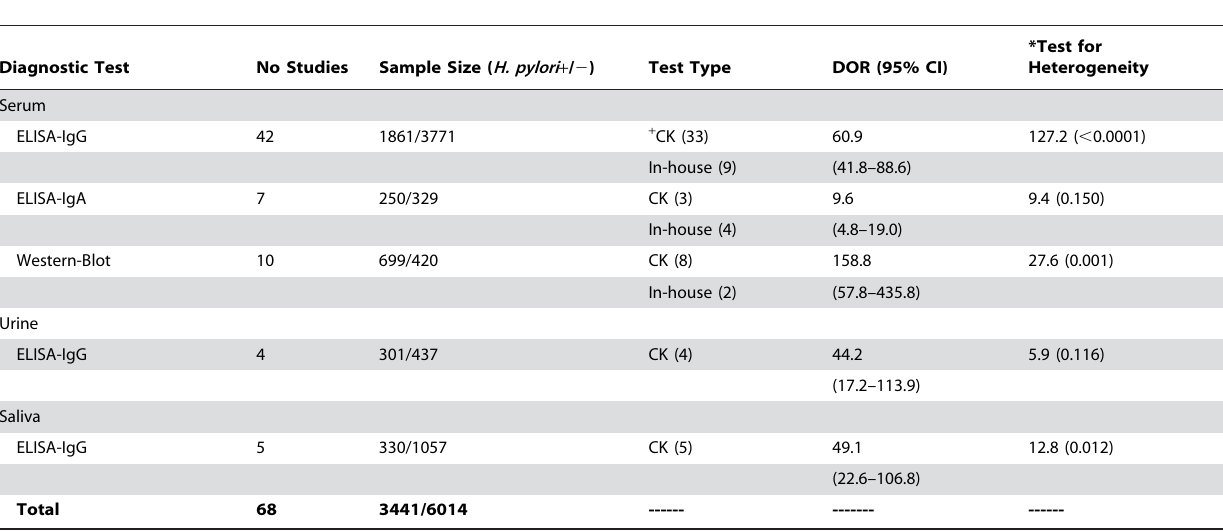
Table 1. Summary of characteristics of the studies included in the